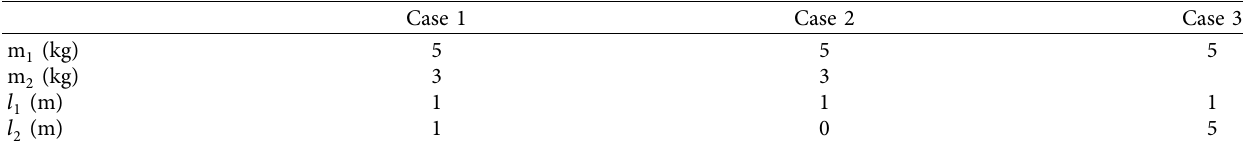
Table 2: Simulation parameters of the manipulator in different